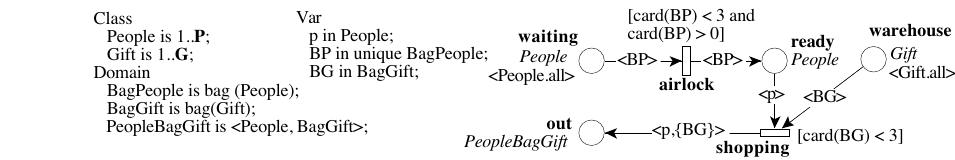
Figure 2. The SaleStore example modeled with a SNB